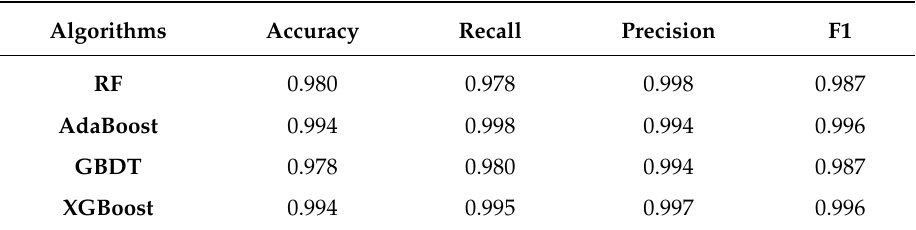
Table 9. Results of UnionPay app identification.